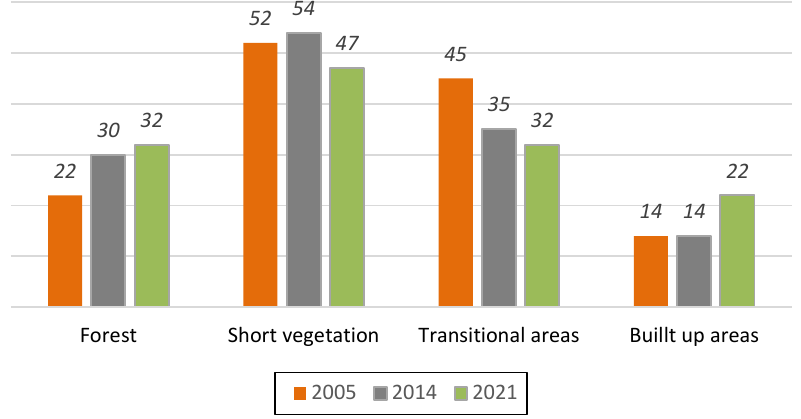
Fig. 5: Summary of land use change, 2005-2017